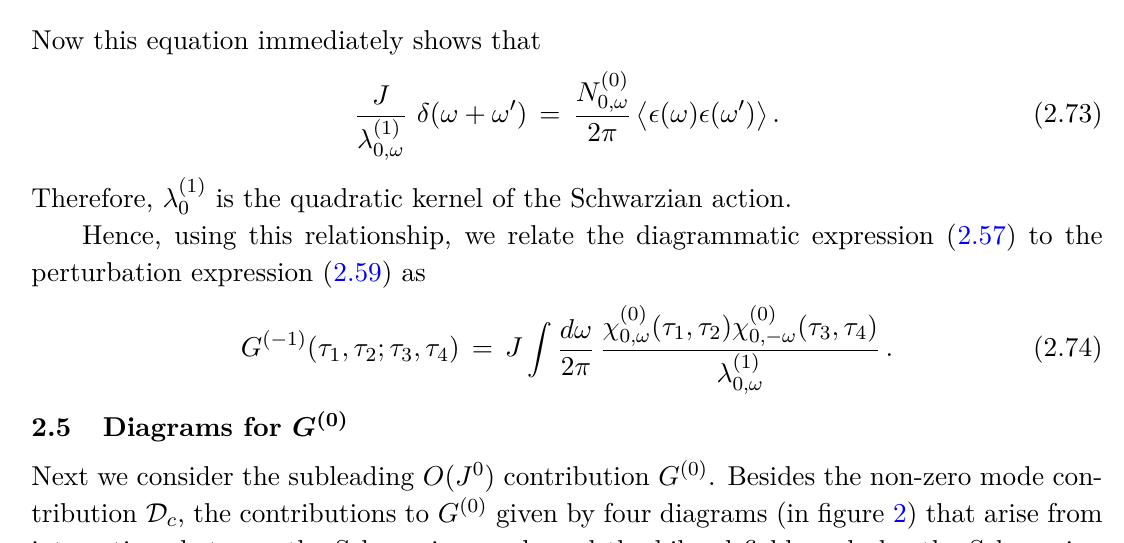
Figure 2 . Diagrammatic expressions for the O ( J 0 ) contributions of the Green’s